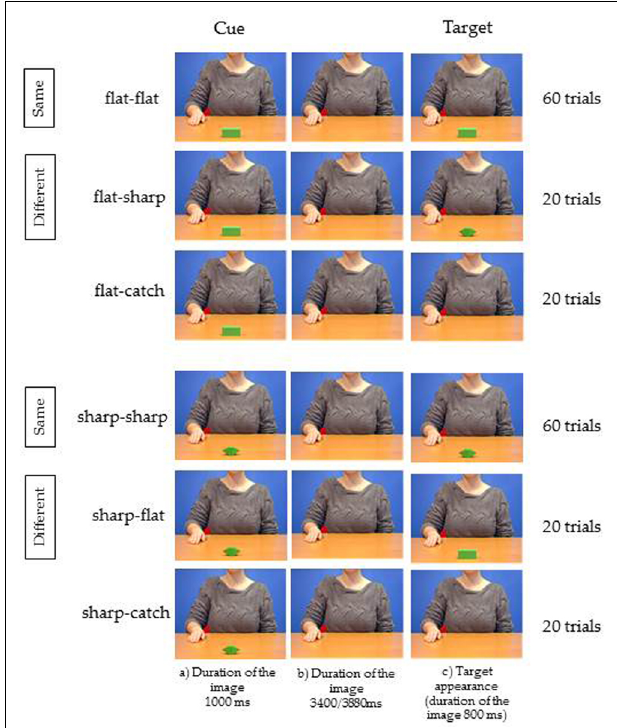
FIGURE 4 | Experiment 2. Three frames relative to each of the six videos used as stimuli. The stimuli and procedure are those described in Figure 1 . The only difference consisted in the fact that the agent shown in the background was not moving, as in Experiment 1, but she was always presented at a rest position as in step (a) of Figure 1